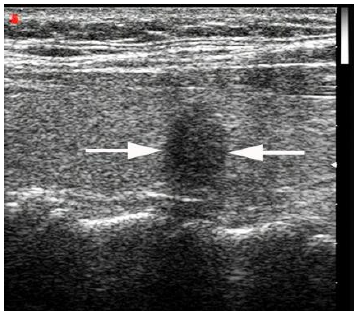
Figure 1. A 48-year-old woman with a PTMC with a taller-than-wide shape in the left thyroid lobe without suspicious thyroid capsule involvement sign (arrows). The patient underwent left central neck lymph node dissection, and the surgical–histopathologic results showed the absence of central neck lymph node metastases. PTMC: papillary thyroid